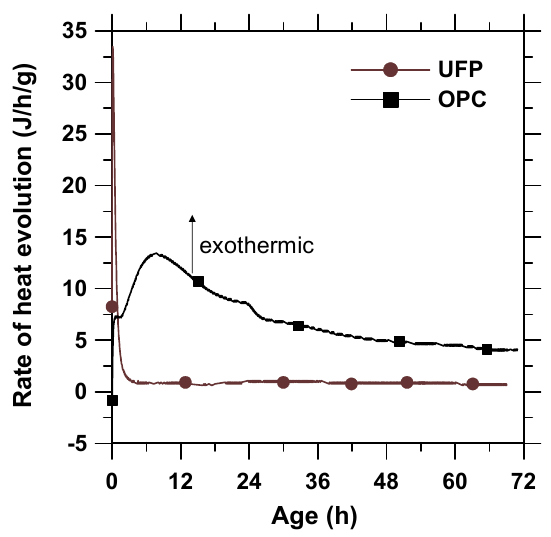
Figure 5. Heat release profile of UFP and OPC pastes during the first 3 days.